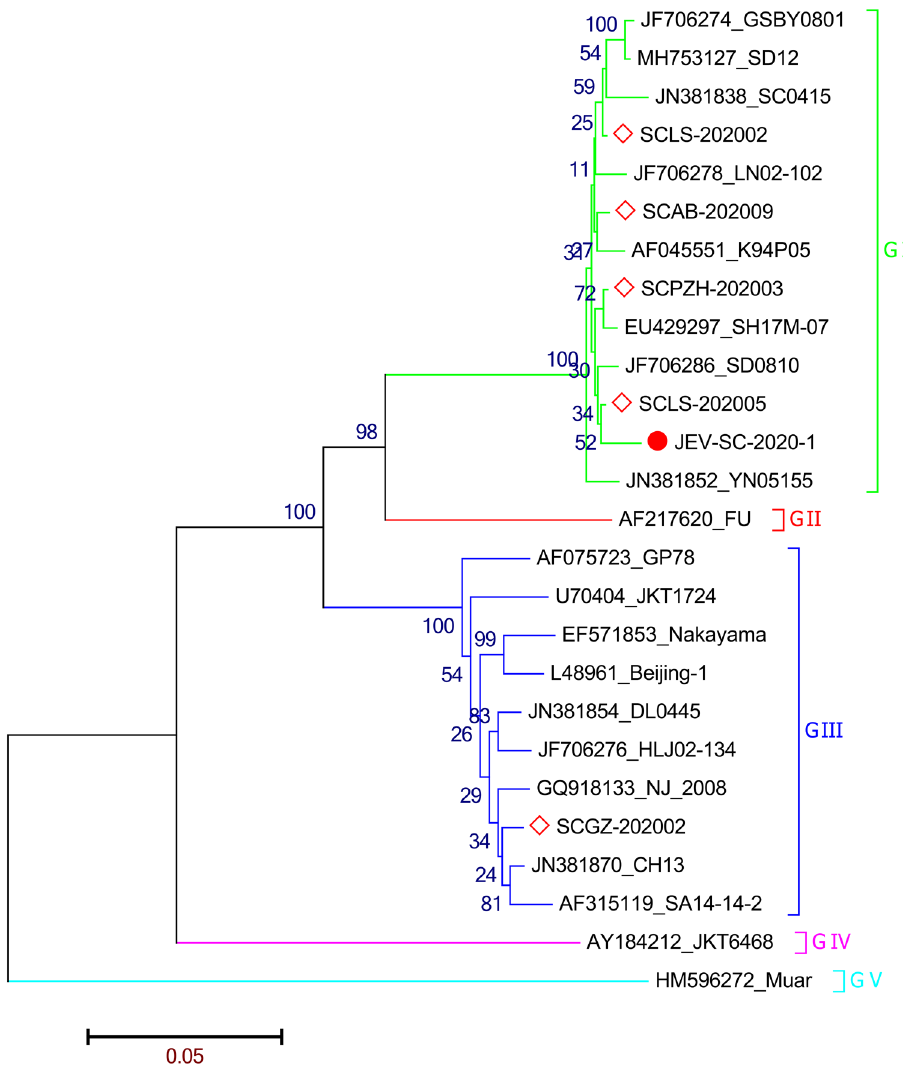
Figure 5. Evolutionary tree analysis of E